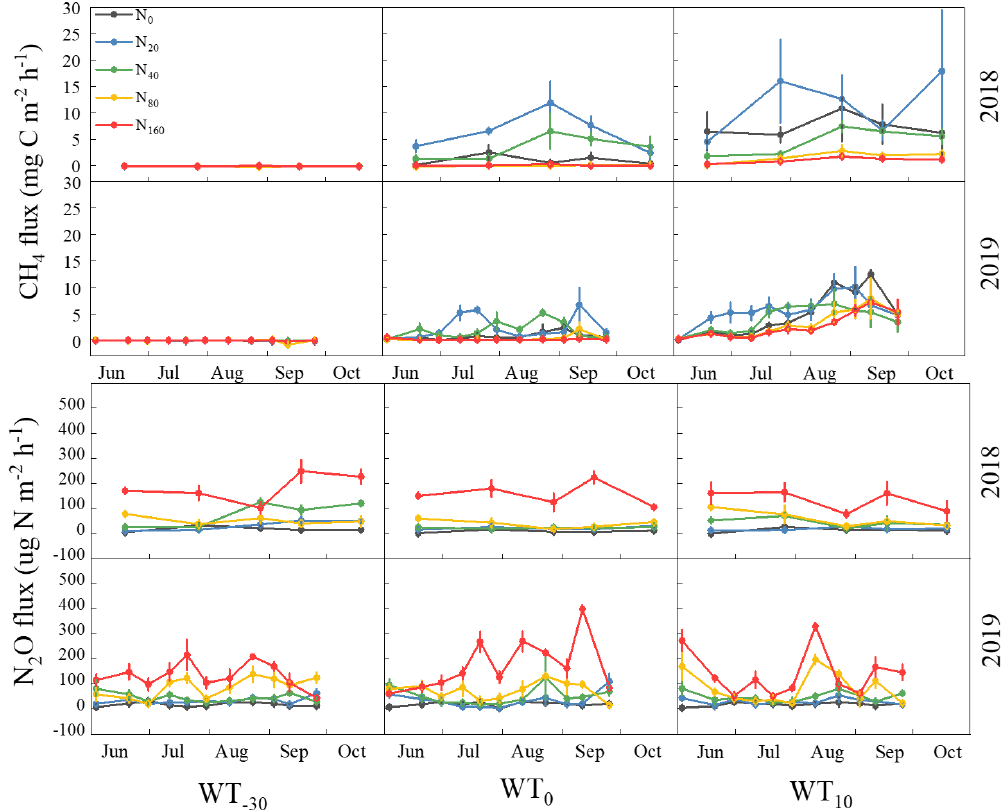
Figure 1. Temporal variation in growing-season CH 4 and N 2 O fluxes under five levels of nitrogen deposition (0, 20, 40, 80 and